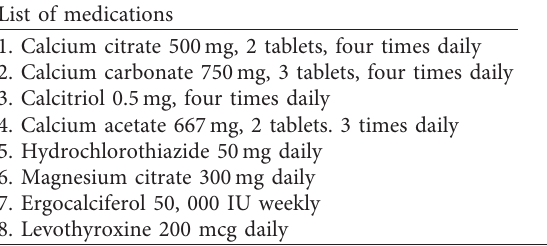
Table 1: List of medications. List of medications